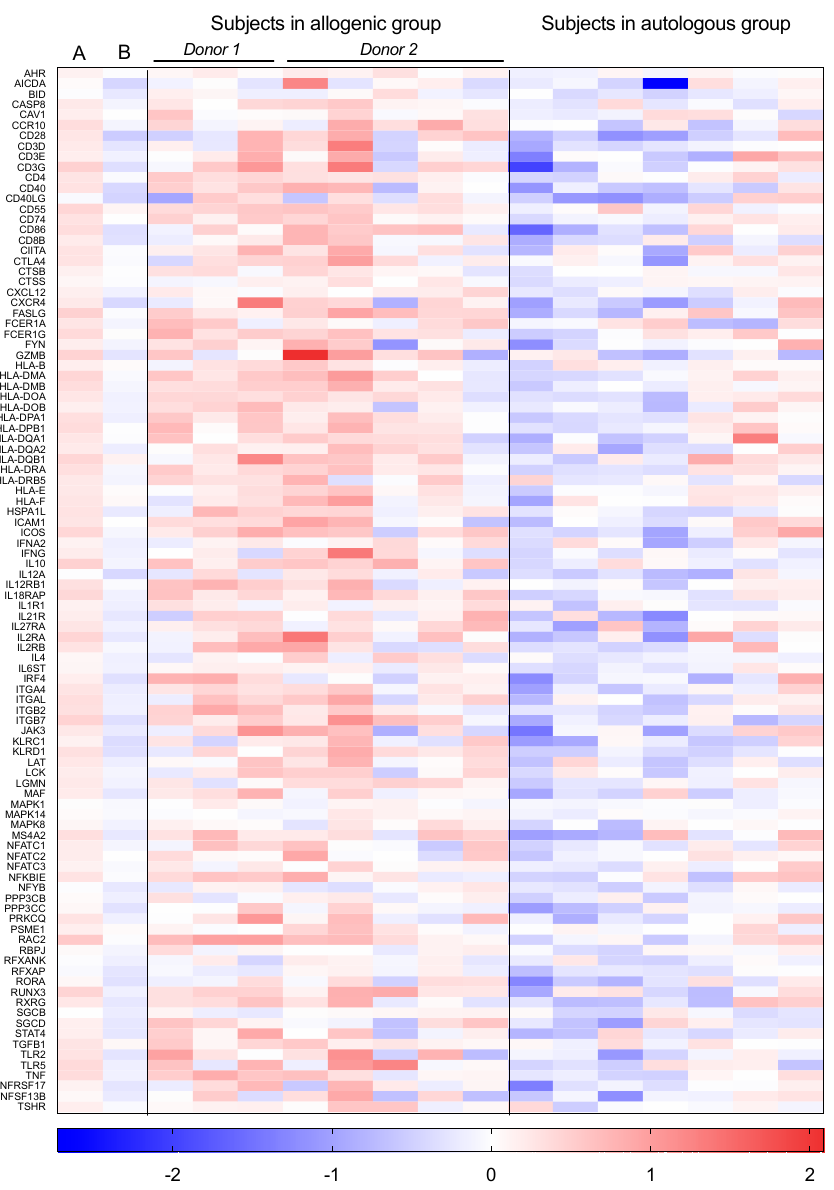
Figure 3. Core enriched genes shared by the gene sets in the largest network of the enrichment map two weeks after FMT. The log2 fold changes of the genes commonly induced in the gene sets within the largest cluster of immune-related gene sets (Figure 2A) are shown. The first two columns show the log2 fold changes after allogenic FMT compared to baseline ( A ) and after autologous FMT compared to baseline ( B ), respectively. The two last panels show the log2 fold changes per subject after allogenic and autologous FMT, respectively. The lines above the subjects receiving allogenic FMT indicate which subject received FMT from which donor.